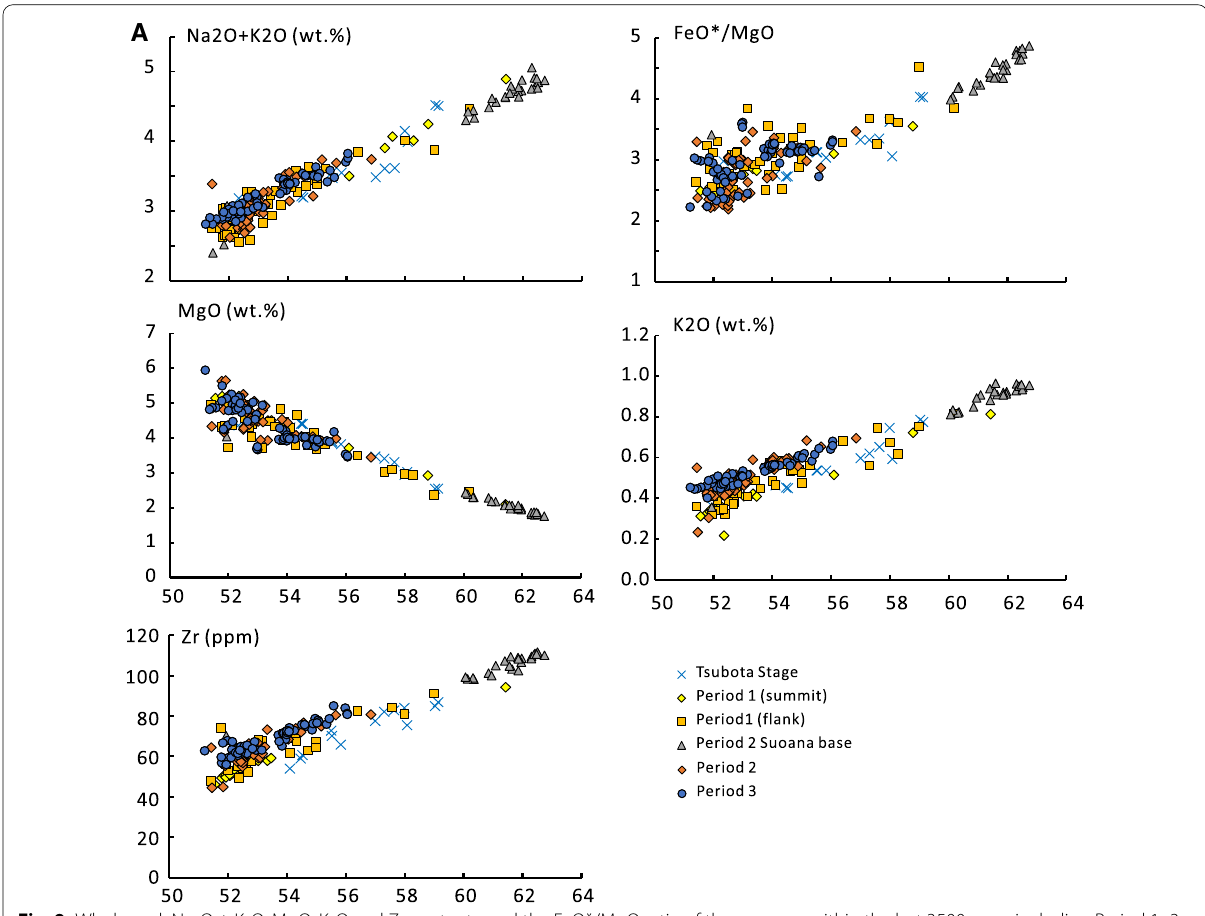
Fig. 9 Whole-rock Na 2 O K 2 O, MgO, K 2 O and Zr contents, and the FeO*/MgO ratio of the magmas within the last 3500 years including Period 1–3 + plotted against their SiO 2 contents in weight percent. All plotted data are normalized as total